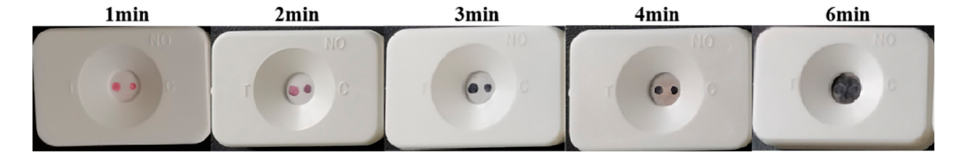
Figure 14. Plot of incubation time results for silver staining.